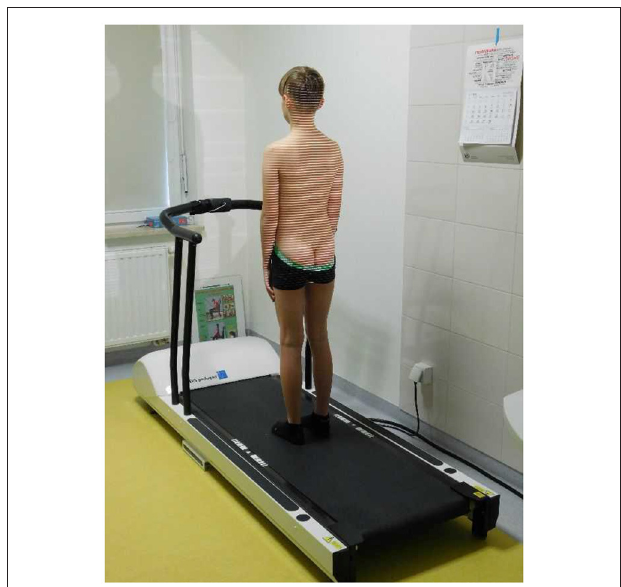
FIGURE 2 | Examination of body posture with the DIERS Formetric 4D system (own source).